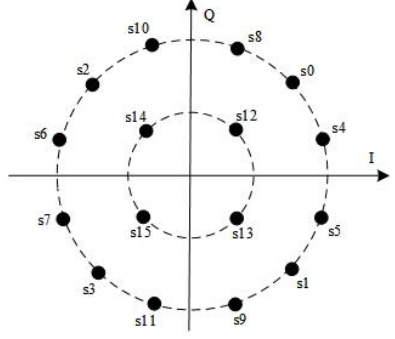
Figure 3. 16-APSK signal constellation. Table 1. Symbol decision and phase rotation angle rules of phase discriminator used in decision feedback loop.